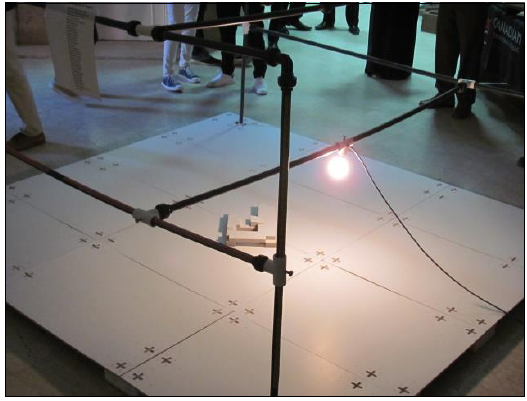
Figure 8. Using the heliodon to test the effect of sunlight on a building